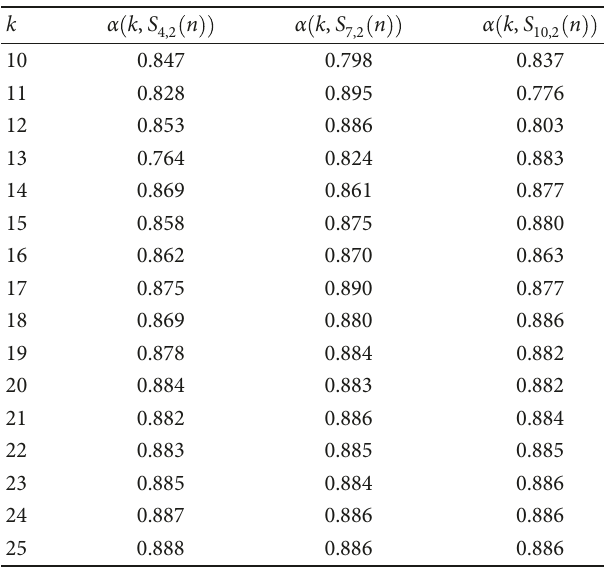
Table 1: Values of α k , S 10 ≤ k ≤ 25